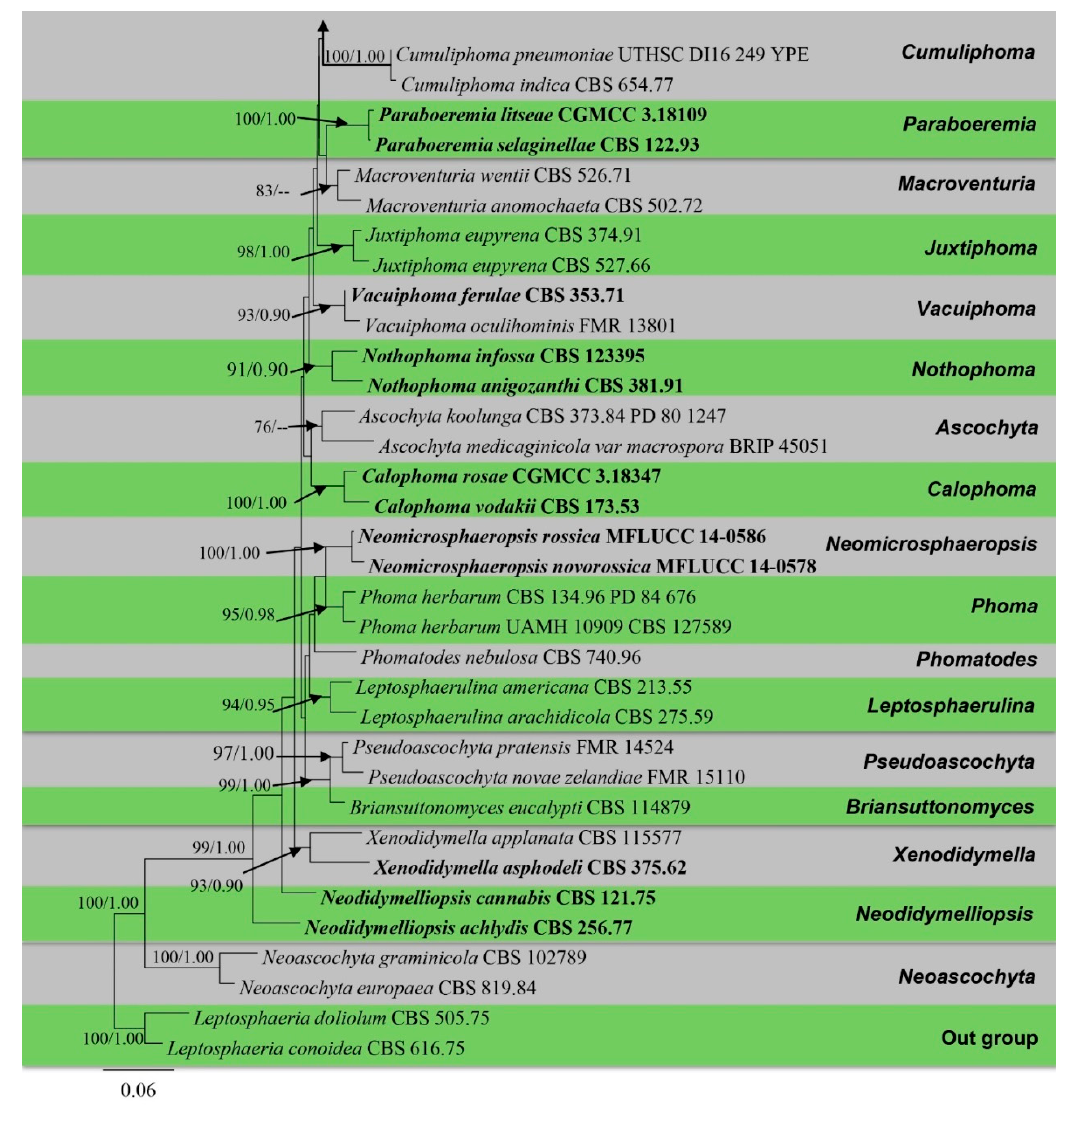
Figure 2. Phylogram generated from a maximum likelihood analysis based on a combined ITS, LSU, RPB2, and β - tubulin sequence alignment. Maximum likelihood bootstrap support values greater than 70% and Bayesian posterior probabilities greater than 0.90 are given at the nodes. The tree is rooted with Leptosphaeria conoidea (CBS 616.75) and Leptosphaeria doliolum (CBS 505.75). Ex-type strains are given in bold and the newly generated sequences are indicated in red bold.